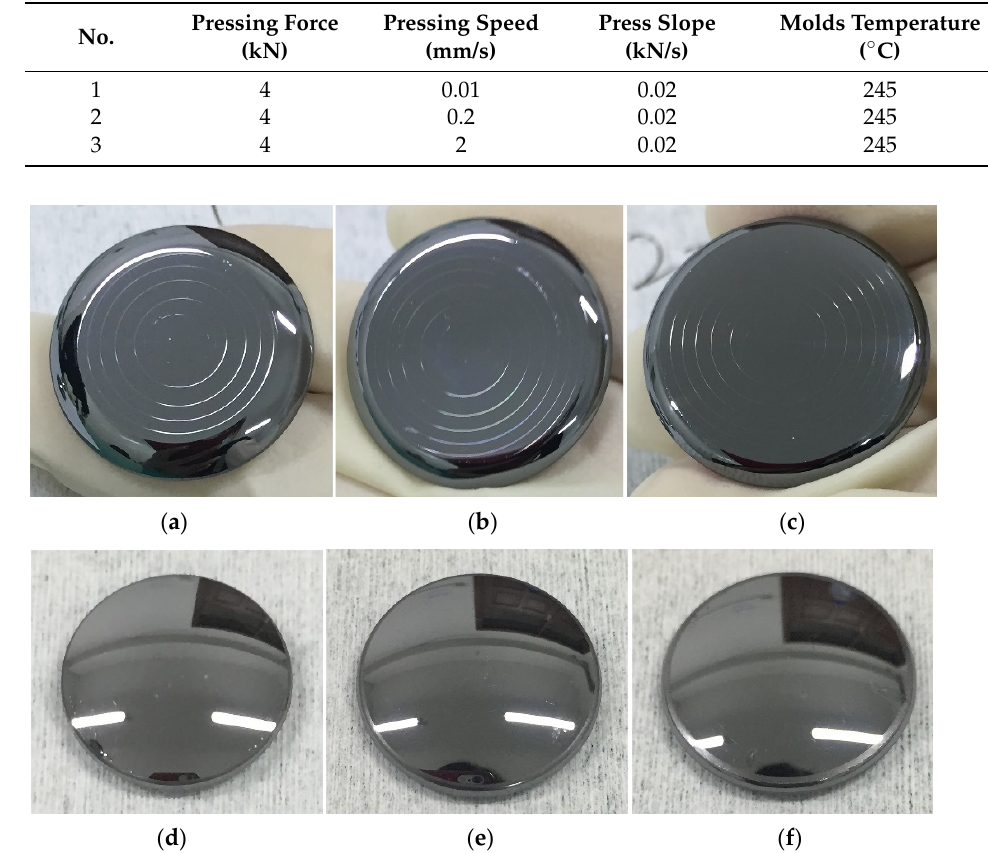
Figure 2. Schematic diagrams of the ( a ) glass preform and ( b ) designed lens. Rapidly solidified aluminum RSA-905 was selected as the mold core material. Three PGM experiments were carried out with the processing parameters listed in Table 2. The photographs of the molded lens are shown in Figure 3. The difference among the molded diffractive surfaces was obvious, while the difference among the molded aspherical surfaces was small. Table 2. The processing parameters of the precision glass modelling (PGM) experiments.